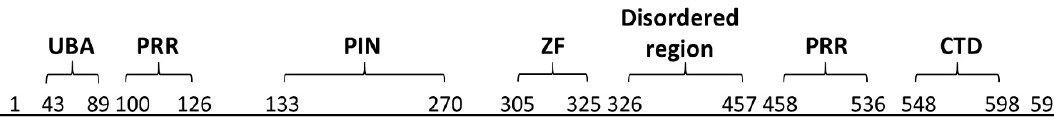
Table 1. mRNA of cytokines and chemokines degraded by MCPIP1 in various types of cells.